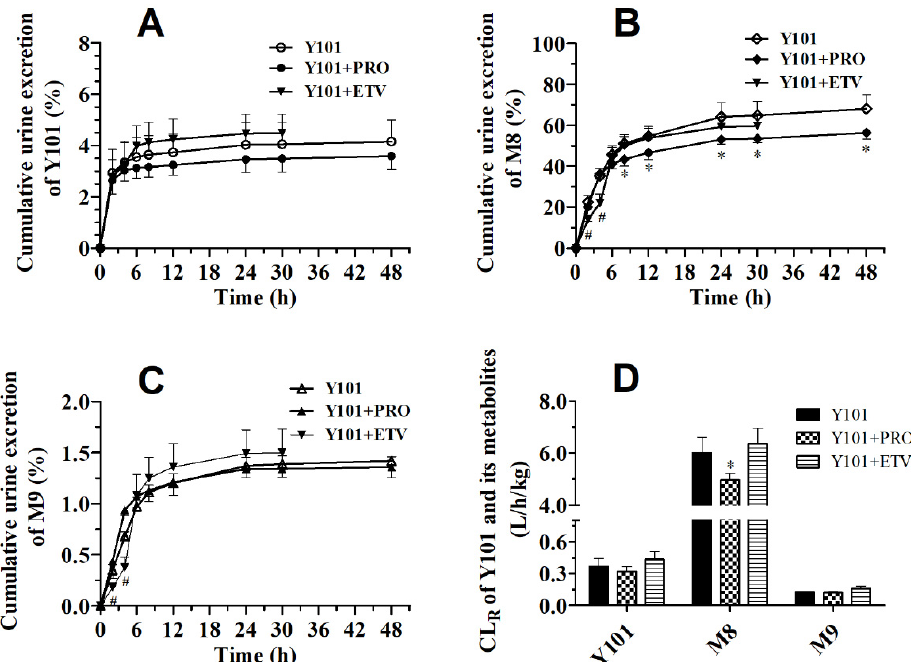
Figure 2. Cumulative urine-excretion curves of Y101 ( A ), M8 ( B ) and M9 ( C ) and the renal clearances of Y101 and its metabolites ( D ) after intravenous administration of Y101 (25 mg/kg), Y101 + PRO (100 mg/kg) and Y101 + ETV (0.06 mg/kg). Data are expressed as mean ± SD (* p < 0.05 vs. Y101 group; n = 6).